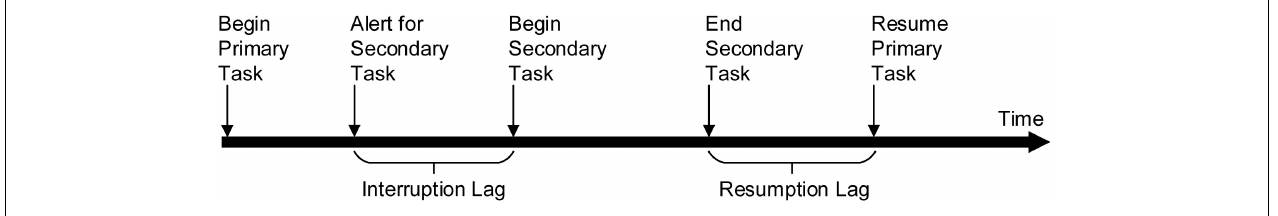
FIGURE 1 | Timeline of the task interruption process proposed by Trafton et al.